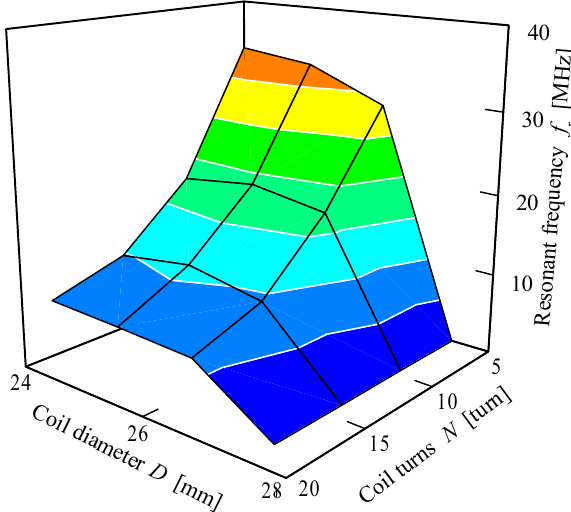
Figure 7. Frequency characteristics for the air